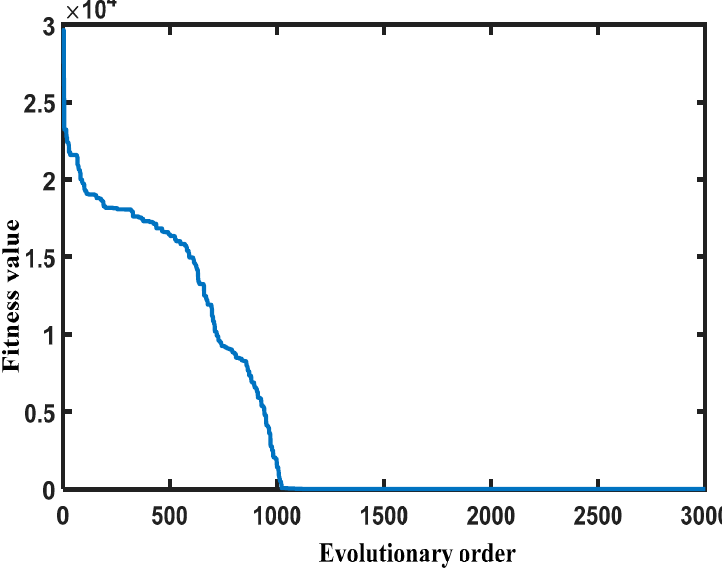
Figure 6. The convergence curve of the three-layer charge model. Table 1. Parameters of the three-layer charging model of thunderstorm clouds.